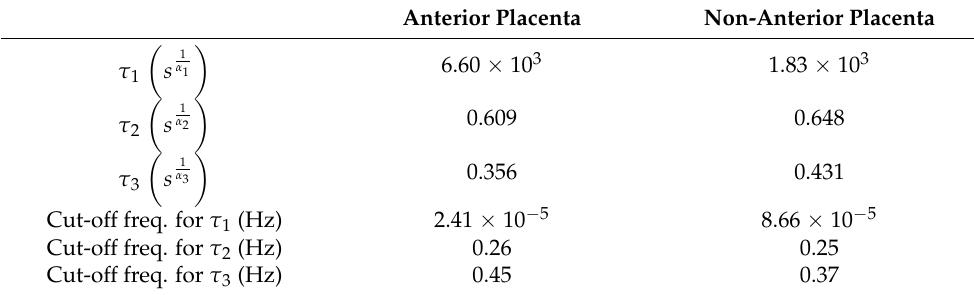
Table 3. Time constants and cut-off frequencies for H ( s